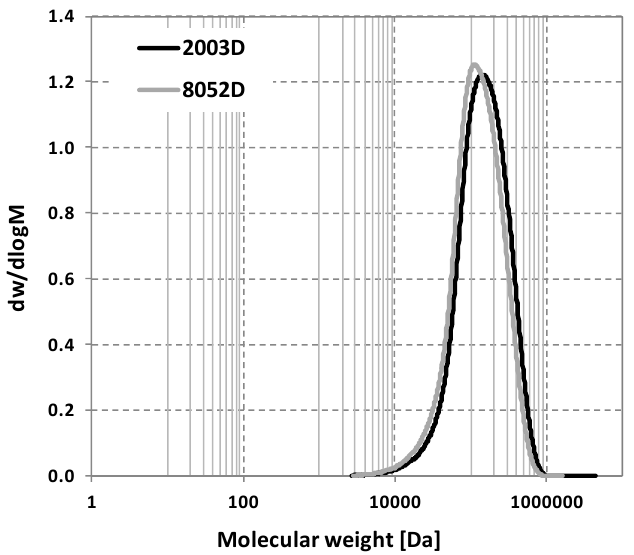
Figure 1. The molecular weight distribution of different poly(lactic acid) (PLA) granules based on a gel permeation chromatography (GPC) test.